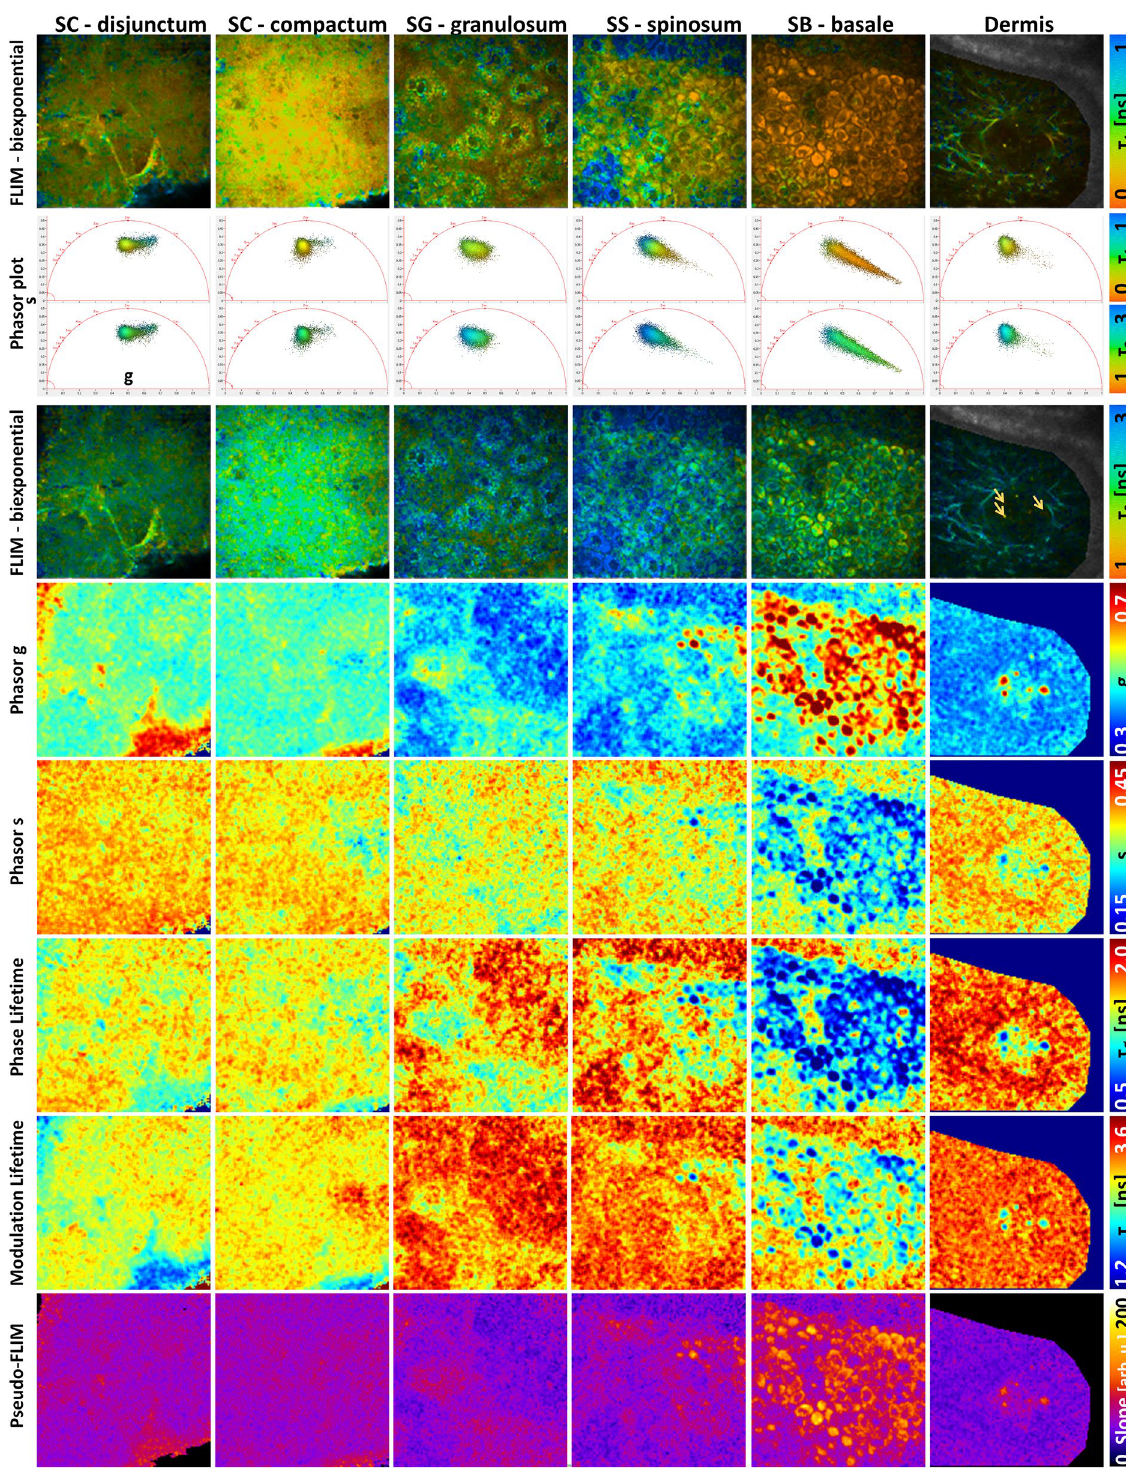
Figure 4. Comparison of FLIM bi-exponential fitting, Phasor and Pseudo-FLIM methods for melanin detection in vivo on human skin. Multiphoton 2D 2PEF FLIM images acquired at different depths from the skin surface to the dermis, within stratum cornuem (SC) disjunctum , corneum compactum , granulosum (SG), spinosum (SS), basale (SB) and superficial dermis were analyzed with the three methods. (top) FLIM bi-exponential fitting analysis images of the short τ 1 and long τ 2 fluorescence lifetime parameters. (middle) Phasor analysis images of g, s, phase lifetime and modulation lifetime parameters. The corresponding phasor plots (s versus g scatters) of the different skin layers are inserted in between the τ 1 and τ 2 images and color coded using the same color scale as for τ 1 and τ 2 parameters. An enlarge view is shown in Fig. S2. (bottom) Pseudo- FLIM analysis images of the slope parameter highlighting pixels with a fast decay. The arrows indicate the fast decay pixels within the blood